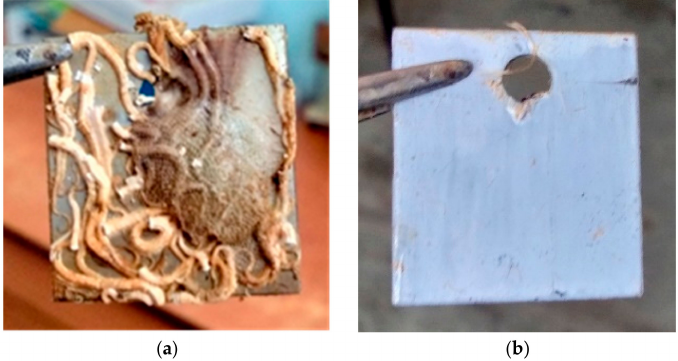
Figure 12. Surface of ( a ) the uncoated and ( b ) the coated SS316L after 30 days of immersion (coupon dimension: 25 mm × 25 mm × 3